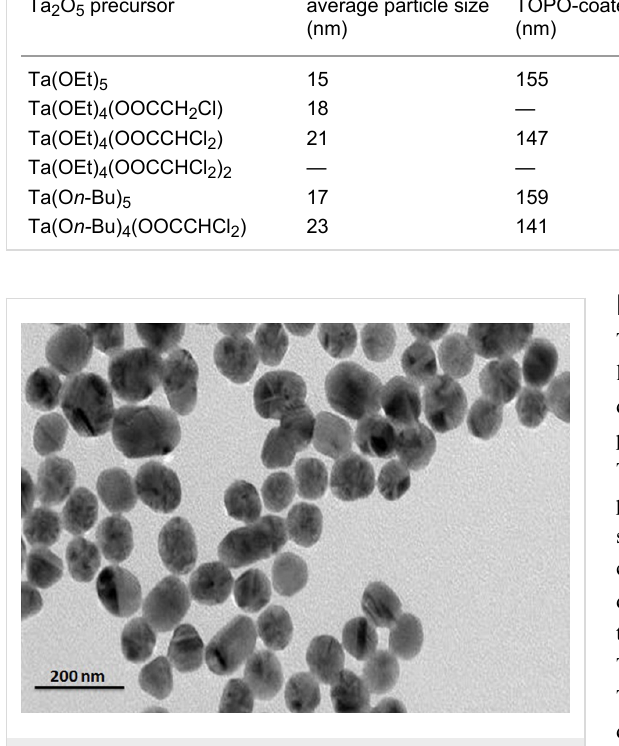
Figure 2: TEM image of Ta 2 O 5 nanoparticles obtained from Ta(OEt) 4 (OOCCH 2 Cl).